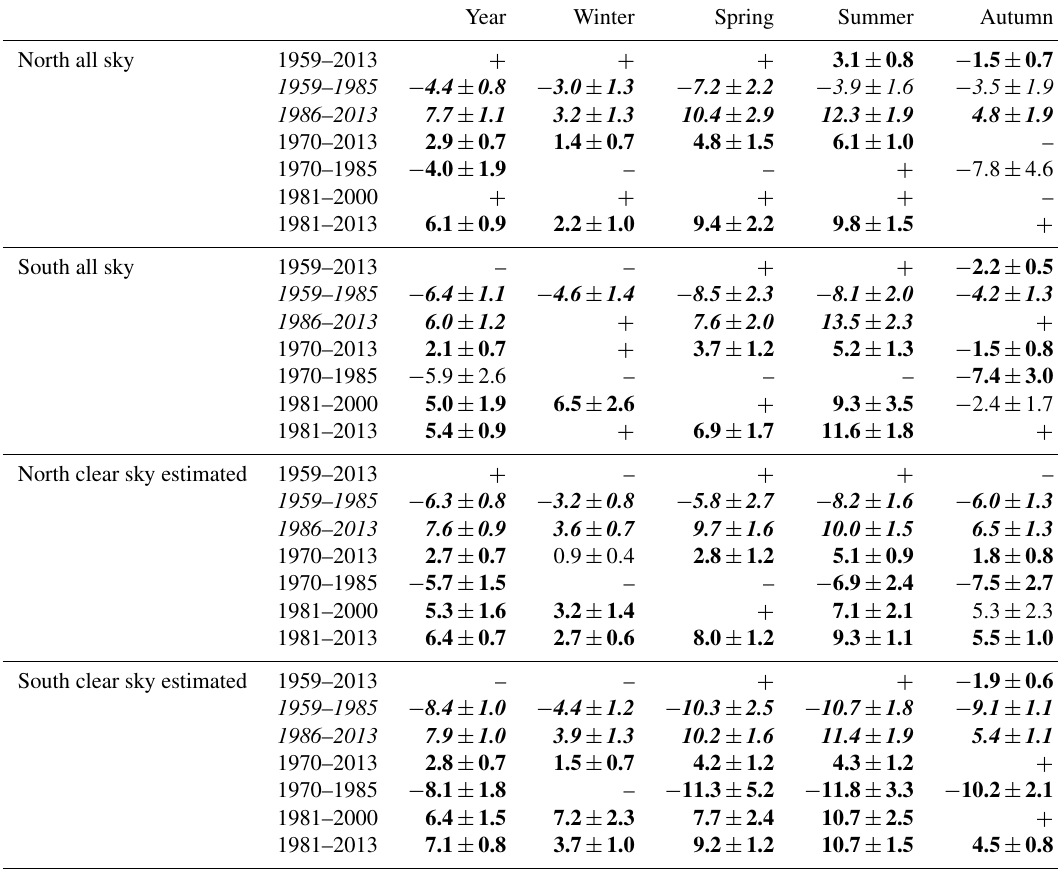
Table 2. Absolute SSR trends in northern and southern Italy under all-sky conditions and estimated trends assuming no changes in cloudiness (see Sect. 3.3). The results concerning the dimming and brightening periods according to the northern and southern Italy annual records are highlighted in italic ∗